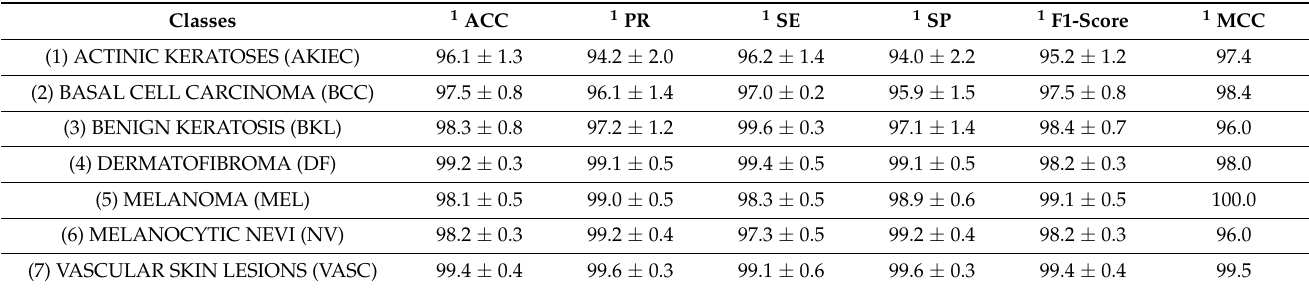
Table 4. Classification results achieve by the proposed ShuffleNet-Light for recognition of the seven classes of PSLs.